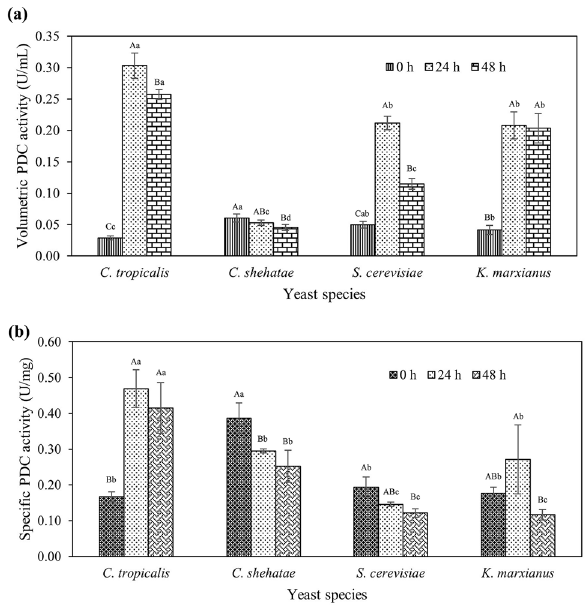
Figure 3. Intracellular pyruvate decarboxylase (PDC) activity of yeasts during cultivation with rice straw as substrate ( a ) Volumetric PDC enzyme activity of cells lysate; ( b ) Specific PDC enzyme activity of cells lysate. Error bars indicate the standard error from the mean (n = 3). Means with different uppercase alphabets indicated a significant difference (p ≤ 0.05) between time intervals of the same yeast species. Means with different lowercase alphabets indicated a significant difference (p ≤ 0.05) between respective time points among yeast